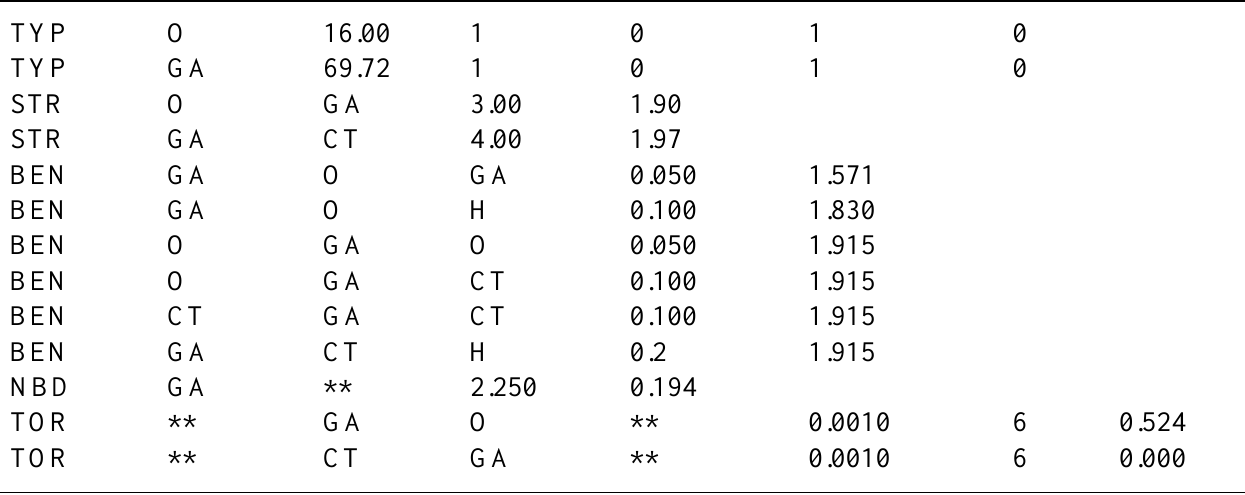
Table 5 . Gallium-related extra parameters used to simulate structures with MOMEC